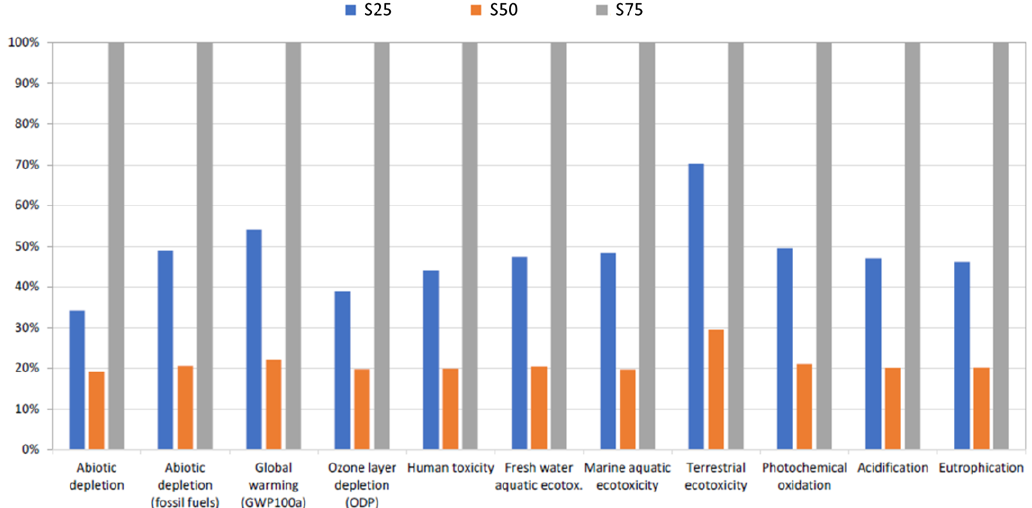
Figure 2. Comparison of the life cycle impact of 1 kg of lemons for the three substrate alternatives, using the CML-IA baseline methodology, showing the characterization stage. Relativized values are shown as a percentage with respect to the greatest impact recorded in each category.